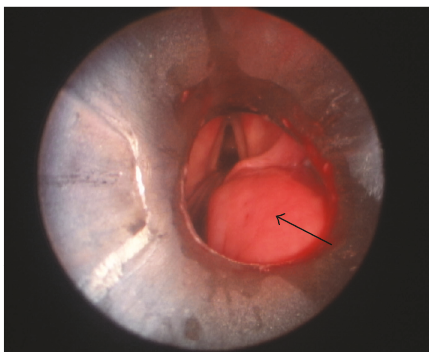
Figure 2: Photograph obtained during direct laryngoscopy showing fullnessoftheposteriorrightoropharynxandhypopharynx(arrow).